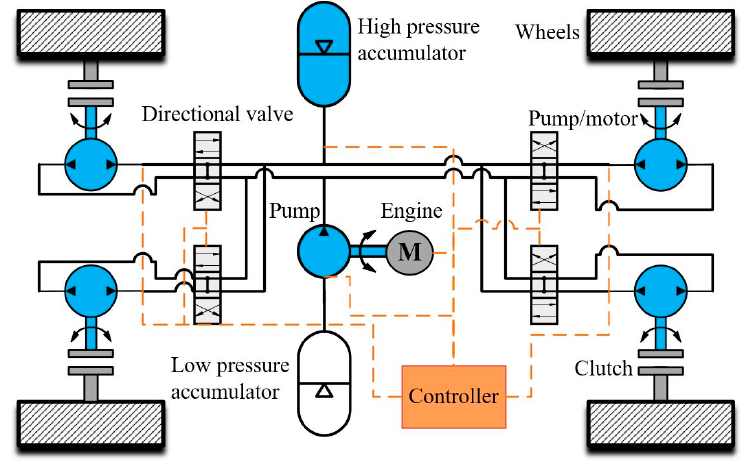
Figure 1. Schematic diagram of the hydraulic hybrid vehicle with a series connection.